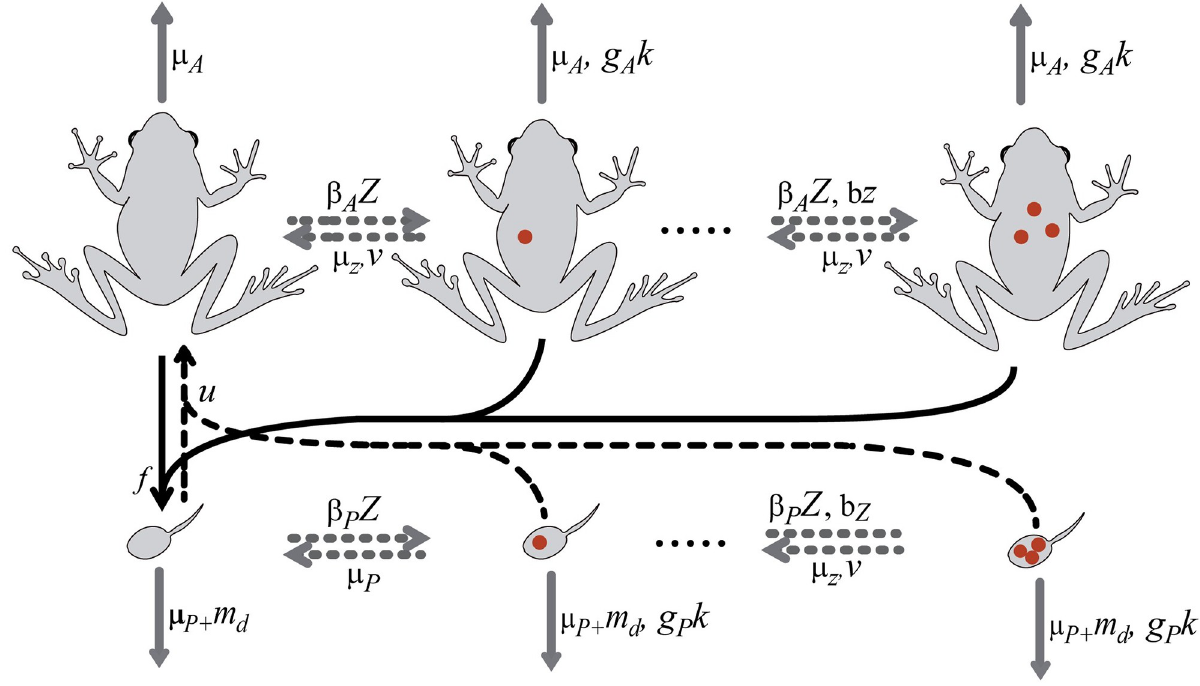
Fig 1. Schematic of the dynamics of Bd infection in reproductive adults and tadpoles. Solid black arrows correspond to reproduction, dashed black arrows to recruitment of tadpoles into reproductive adults, grey dashed arrows to new infections or within-host disease dynamics, grey solid arrows indicate disease-independent or disease-induced